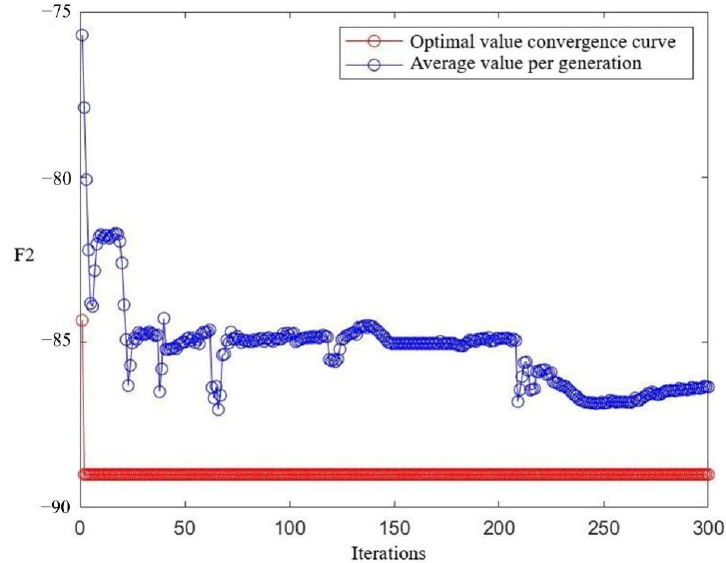
Figure 8. Optimal value convergence curve of the matching degree of the berth and average value curve of each generation.